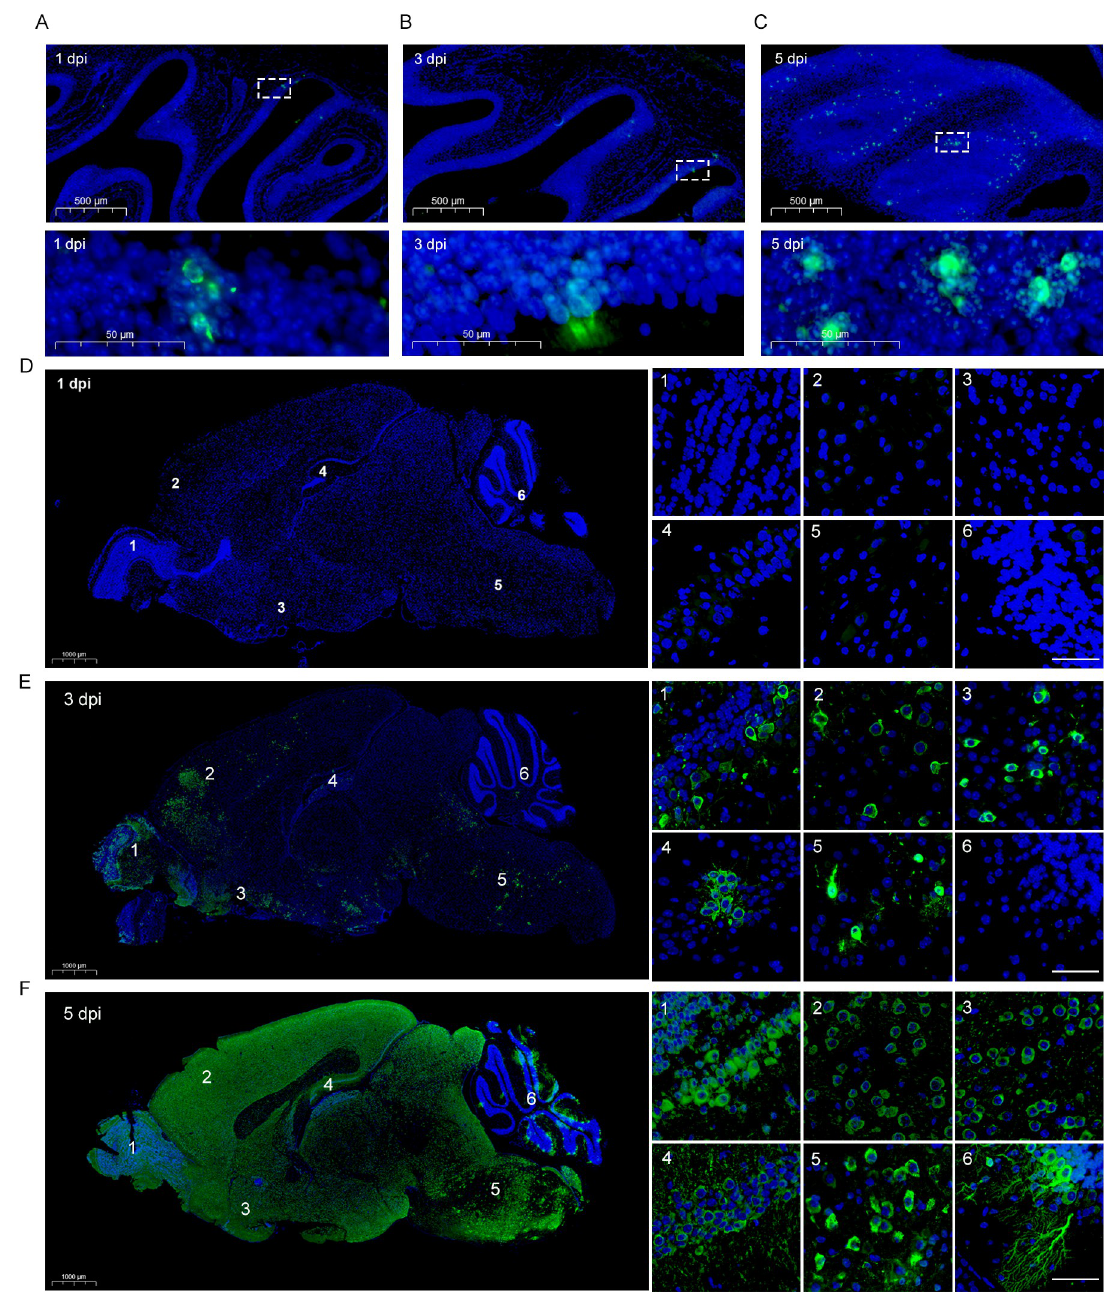
Fig 4. Viral antigen distribution in the mouse OE and brain during PHEV infection. The 3w BALB/c mice were inoculated intranasally with 10 3.96 TCID 50 PHEV and sacrificed at 1, 3 and 5 dpi, respectively. (A-C) Representative images of immunofluorescence staining for viral antigens in the nasal cavity at 1 dpi (A), 3 dpi (B) and 5 dpi (C). The bottom panels show the magnified images of the dashed rectangles. Scale bars, 500 μ m (A-C, top panels), 50 μ m (A-C, bottom panels). (D-F) Representative images of immunofluorescence staining for viral antigens in the brains at 1 dpi ( D ), 3 dpi ( E ) and 5 dpi ( F ). Right panels represent the OB (panel 1 ), cerebral cortex (panel 2 ), piriform cortex (panel 3 ), hippocampus (panel 4 ), brain stem (panel 5 ), and cerebellum (panel 6 ). Scale bars, 1,000 μ m ( D-F , left panels), 30 μ m ( D-F , right panels). PHEV-N (green), DAPI (blue).